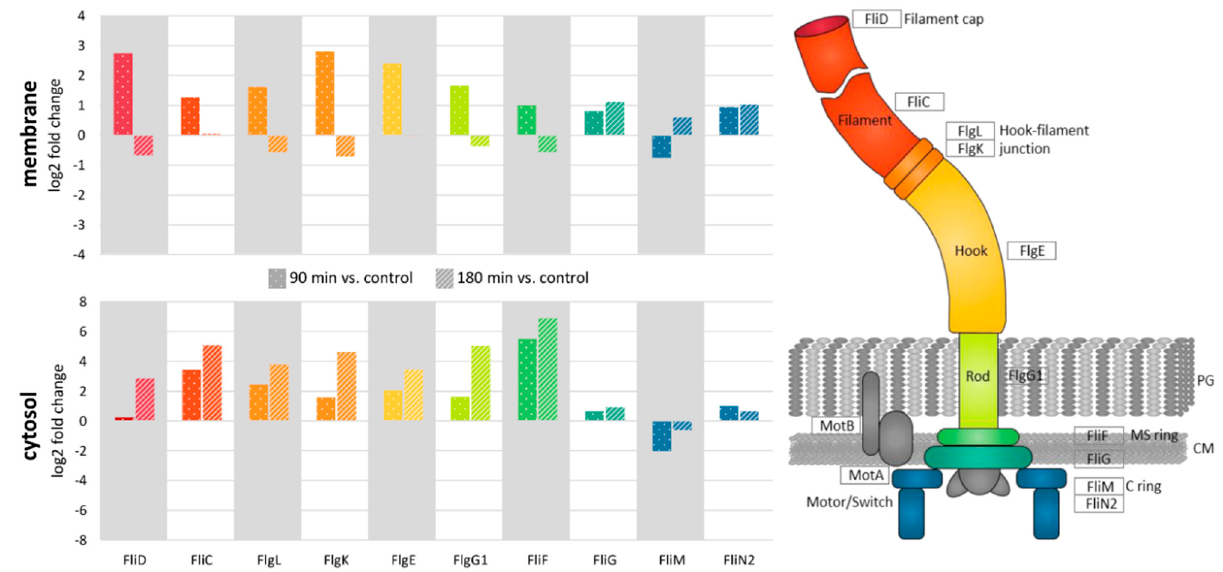
Figure 7. Relocalization of flagella proteins between cytosolic and membrane fraction after nisin treatment. The log2-fold change in protein abundance is depicted for flagella proteins quantified either in the cytosolic (“cytosol”) or the membrane fraction. Log2 ratios are calculated by comparing protein abundances 90 min (dotted bars) or 180 min (striped bars) after nisin treatment, respectively, to the respective protein abundance under control conditions (untreated).